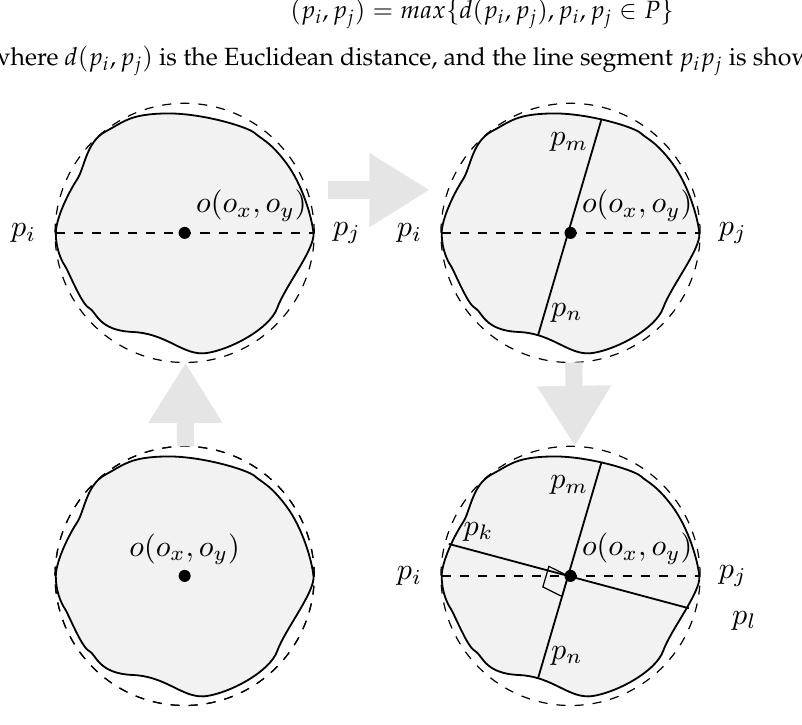
Figure 5. Long and short diameter search process.The line segment p i p j is the diameter of the circumcircle of the contour. The line segment p m p n is the short diameter of the wood which passes through the center o ( o x , o y ) and has the minimum length. The line segment p k p l is perpendicular to the straight line p m p n which passes through the center is considered as the long